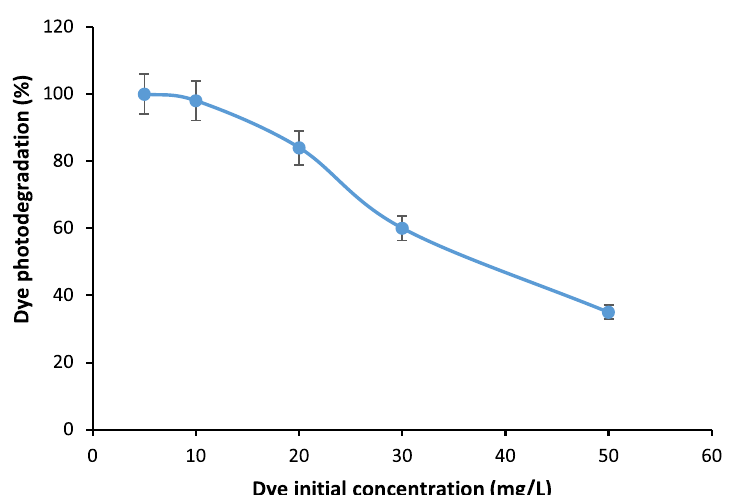
Fig. 11 Effect of the initial dye concentration (dye dye solution volume mg, irradiation time